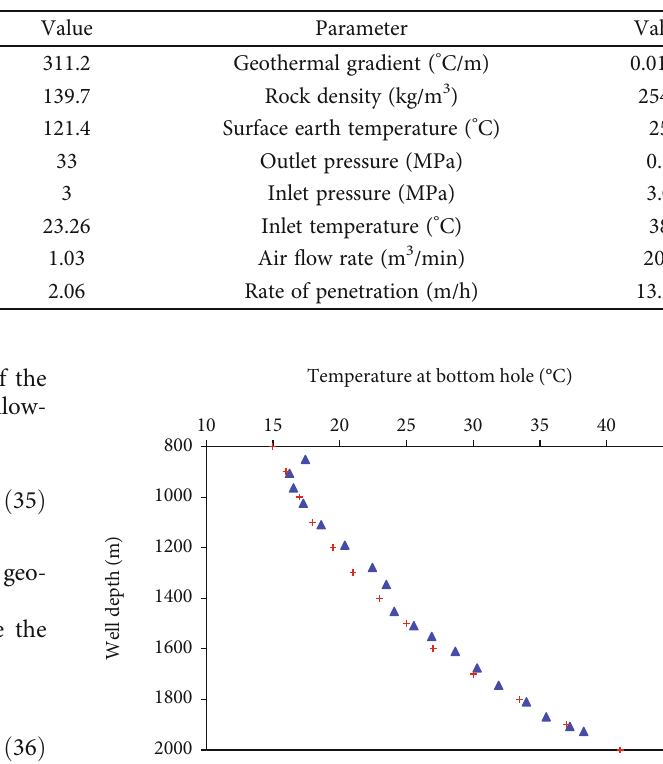
Table 1: Basic parameters of SWC602.